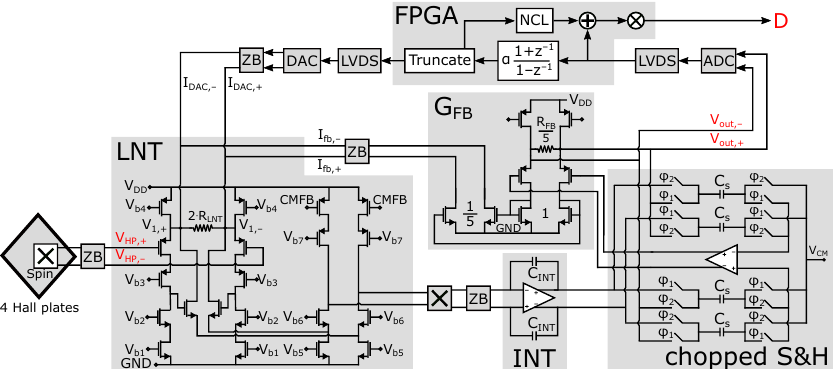
Figure 10. Implementation details of the readout chain used for experimental verification in Section 5 (adapted from (Figure 11 in [13])). Important signals are highlighted in red.